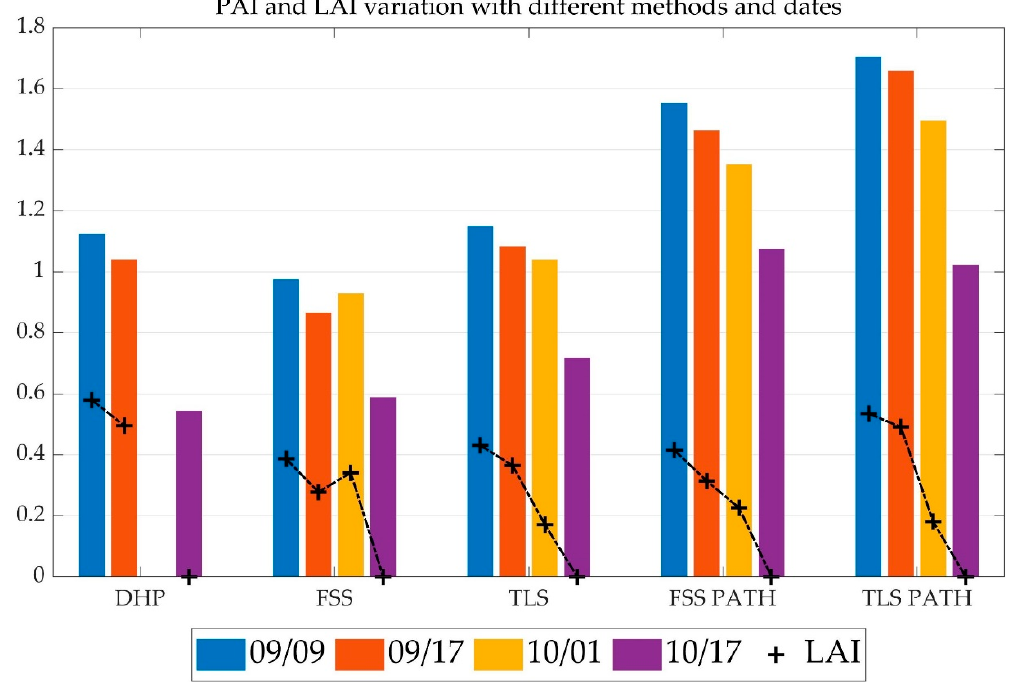
Figure 12. Comparing different methods of leaf area index (LAI) estimation on four scanning dates. The colored bars represent plant area index (PAI), and crosses for the associated LAI. The October 1st DHP dataset is not available. The DHP and the FSS methods are based on RGB images and the TLS based on depth images.